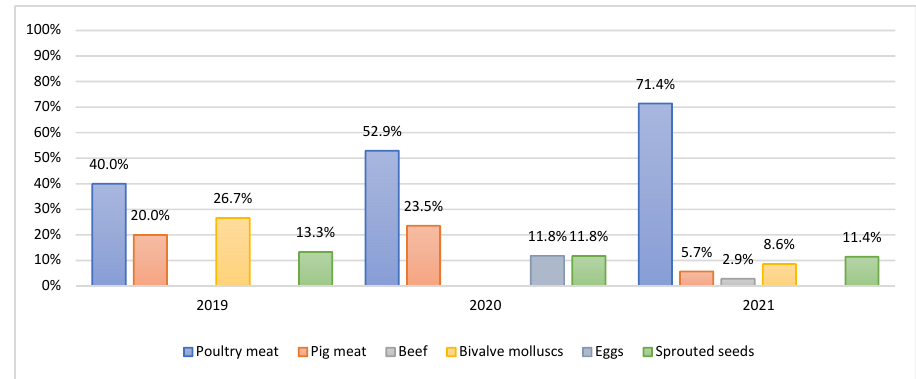
Figure 1. Prevalence per year of Salmonella based on food. S . Infantis was the predominant serotype (48%), present in 32 poultry meat samples. Instead, S. Typhimurium (9%), S. Derby (6%) and S. Enteritidis (3%) serotypes were found to have a low prevalence (Figure 2). Figure 2. Salmonella spp. research results and serotypes identified in the 2019–2021 three-year pe- riod. 3.2. Antibiotic Susceptibility and ESBL Production Test Results Antibiotic susceptibility testing conducted on the 67 Salmonella strains showed the absence of resistance in 24 of these strains, whereas 43 strains (64%) were resistant to one or more of the tested antibiotics. Supplementary Materials Table S1 provides an overview of these strains and their resistances. Notably, 31.3% of these strains were resistant to kanamycin, 43.2% to sulphonamides, 47.7% to nalidixic acid, 49.2% to ampicillin and 50.7% to tetracycline. Few strains showed resistance to levofloxacin (5%) or chloramphenicol (6%), whereas no resistance against imipenem, ciprofloxacin or enrofloxacin was detected. An MDR profile was found in 36 strains that showed resistance to three ( n = 4), four ( n = 22) and five ( n = 10) antibiotic classes (Supplementary Materials Table S1). Specifically,